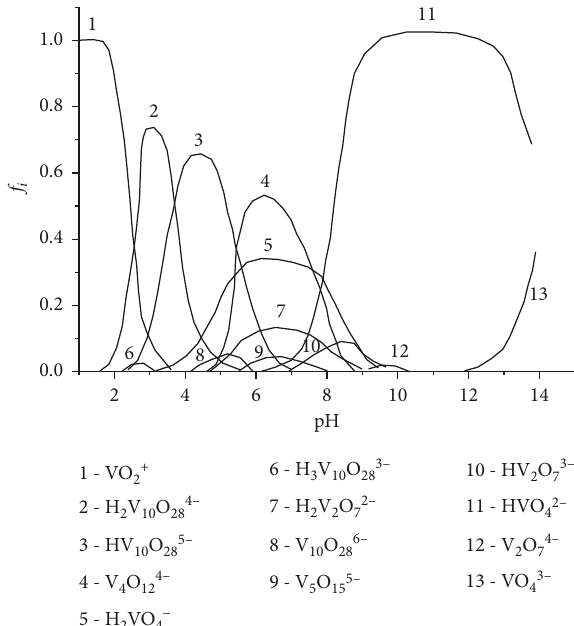
Figure 1: Partial molar fractions of the vanadium V(V) species for C V � 1 · 10 − 3 mol · L − 1 .